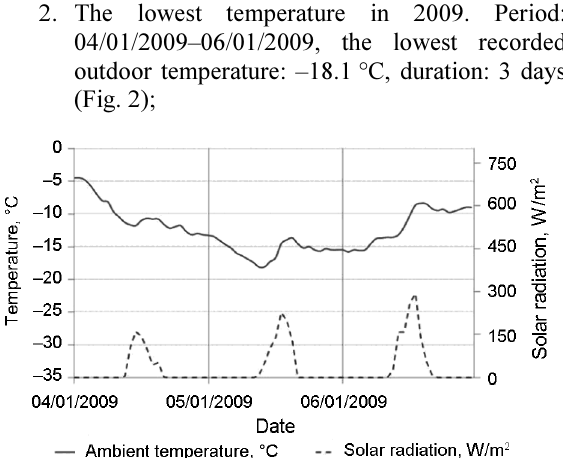
Fig. 2. The lowest temperature s in 2009